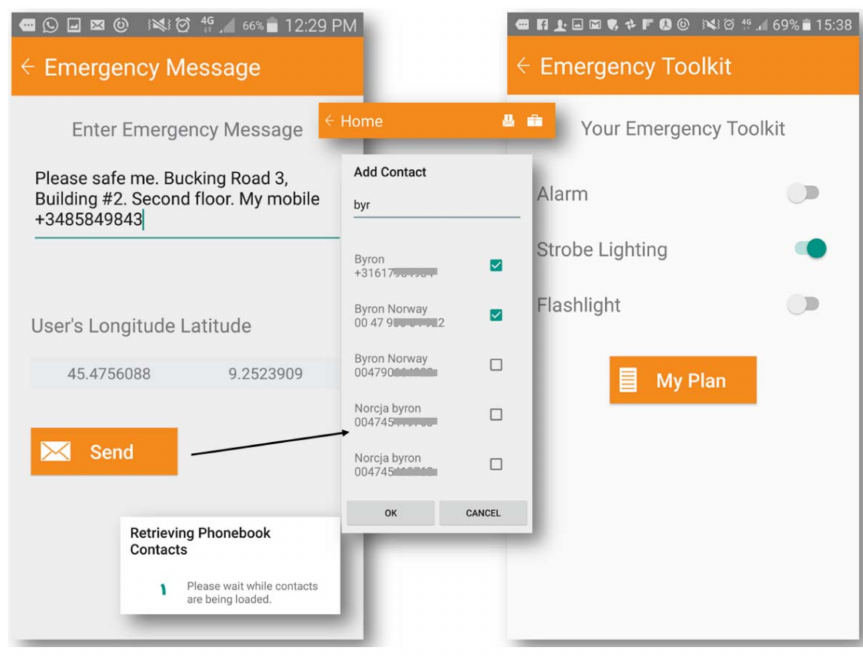
Figure 8. Message for emergency request, and strobe, flashlight, or alarm kit.